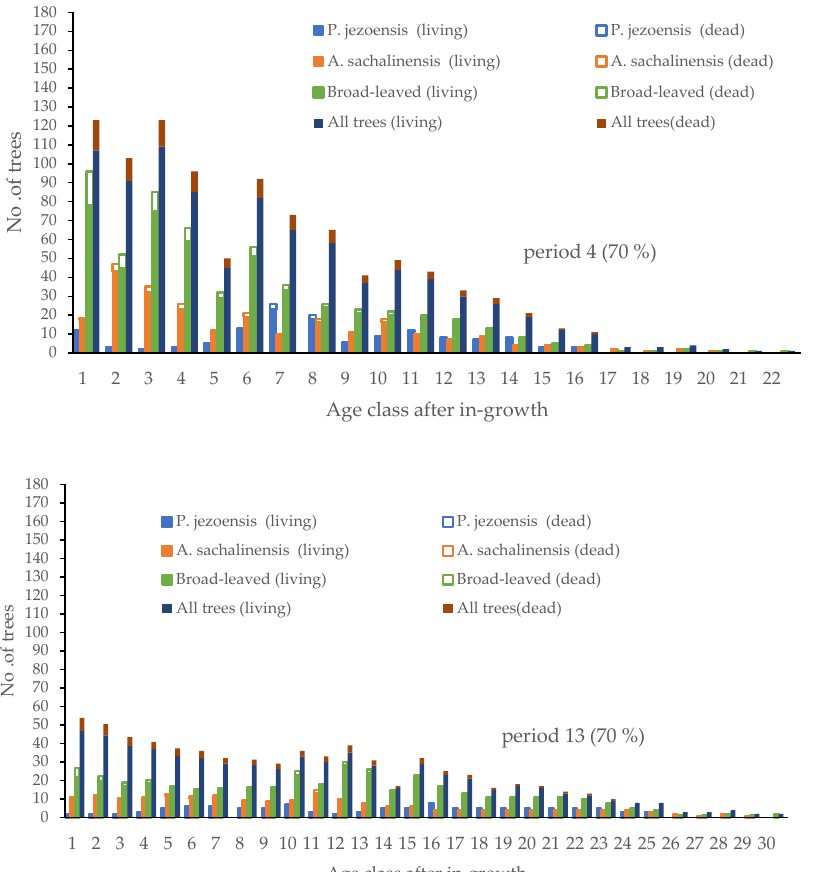
Figure 6. Climax state of major conifer species, broad-leaved trees, and all the trees. By assuming only 70% of dead trees in the previous period to be equivalent to the number of new ingrowth trees in the next period, future predictions were carried out for the next 100 years (Figure 7). For example, in this scenario, three A. sachalinensis trees that belong to the third age class will die in the period 2019–2029 (period 4 of Figure 7). By period 13, all distributions of tree categories reached exploitational and multi-modal shapes.